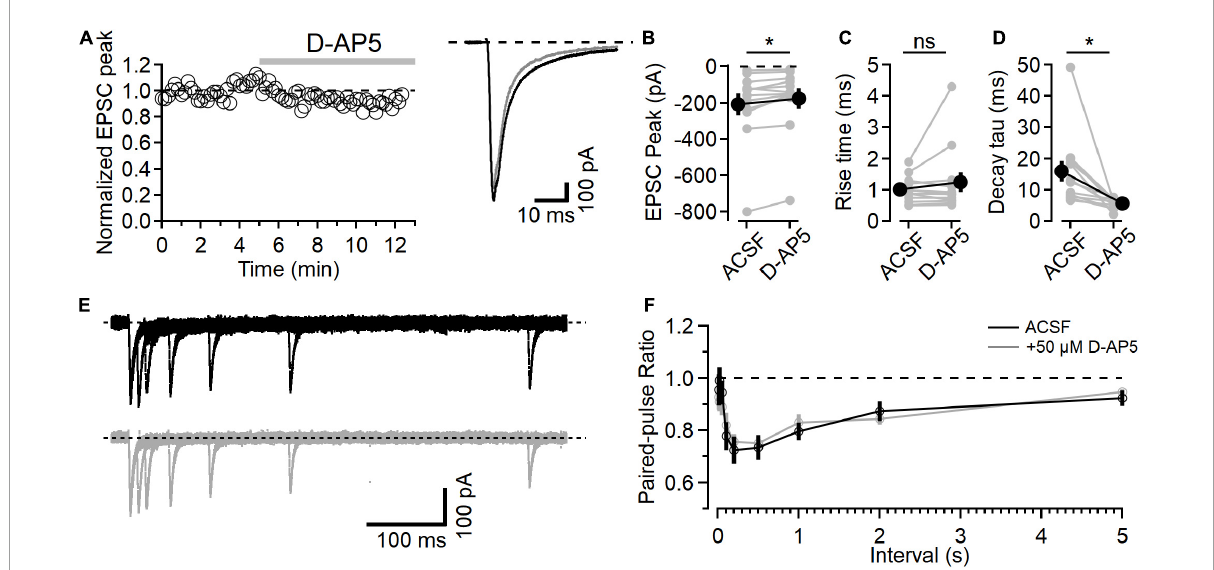
FIGURE1 NMDARs contribute to L4-L2/3 EPSCs. (A) Left, example time course of EPSC peak measurements in response to bath application of 50 µ M D-AP5. Right, average response in control ACSF (black) and after D-AP5 (gray). (B) Peak EPSC is reduced after D-AP5 application ( p = 9.3E-3, Wilcoxon rank-sum test, n = 12). (C) EPSC 20–80% rise time is not significantly changed after D-AP5 application. (D) EPSC decay time is significantly reduced by D-AP5 (weighted tau calculated from two-exponential fit to decay phase of EPSC; p = 4.9E-4, Wilcoxon rank-sum test, n = 12). (E) Example traces showing paired-pulse responses at different intervals before (black) and after D-AP5 (gray). (F) No difference in PPR measurements was detected between control (black) and D-AP5 (gray) conditions [Friedman test statistic = 11.9 (15.5), p = 0.21, n = 11]. *Indicates p < 0.05; ns indicates not